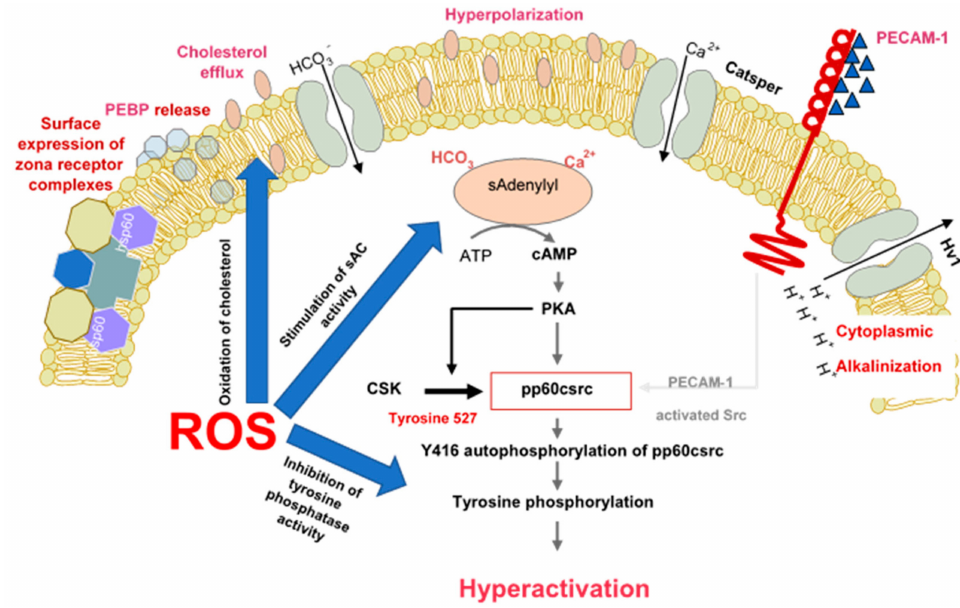
Figure 1. The role of reactive oxygen species in the induction of sperm capacitation. The latter is a complex process involving hyperpolarization of the sperm plasma membrane, cytoplasmic alkalinisation as a consequence of proton extrusion via the Hv1 proton channel, calcium entry via Catsper and a global increase in tyrosine phosphorylation mediated by cAMP. ROS (reactive oxygen species) are involved in several aspects of capacitation including cholesterol oxidation and extrusion, stimulation of soluble adenylyl cyclase (sAC) and suppression of tyrosine phosphatase